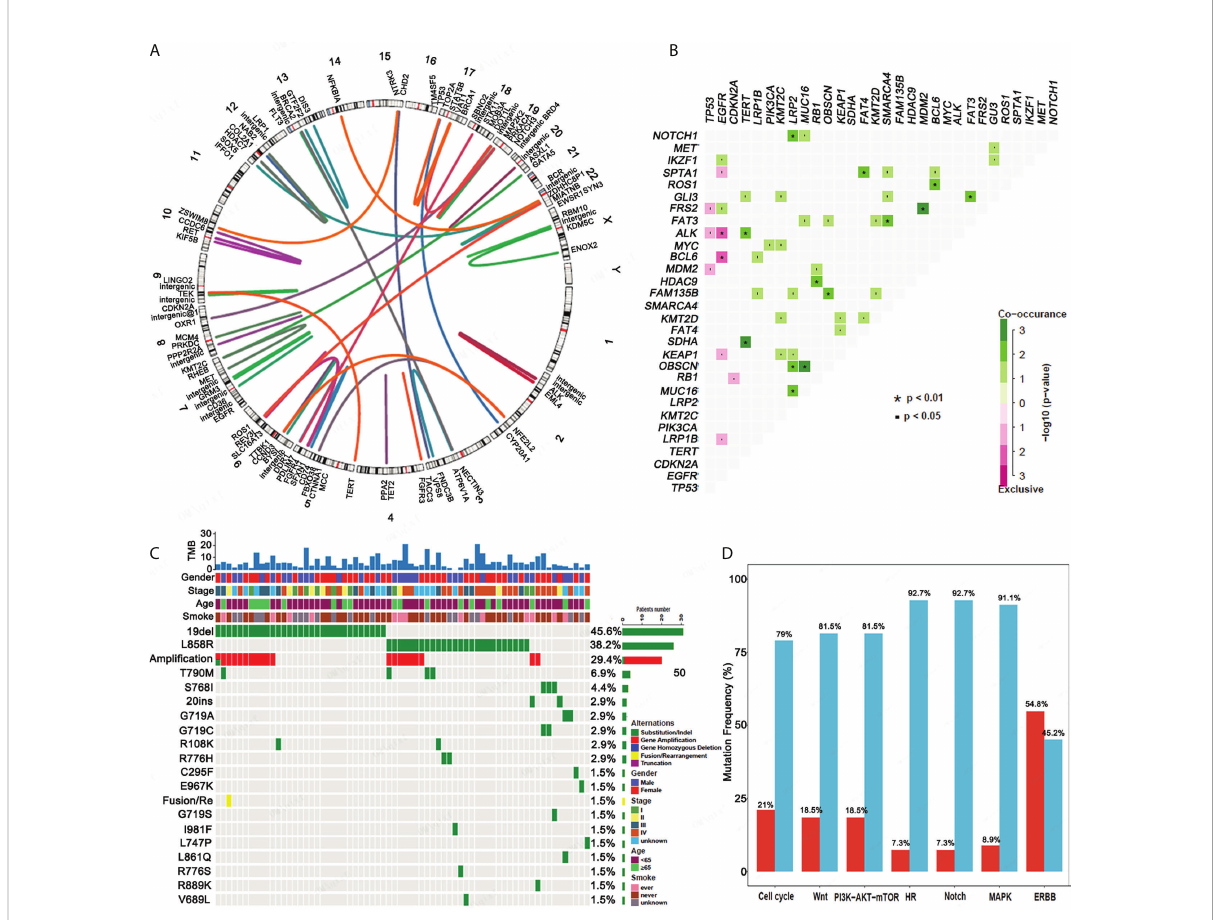
FIGURE 2 Gene fusion, co-mutation, EGFR mutations and mutational gene pathways for ASC. (A) An analysis of the gene fusion/rearrangement characteristics for ASC patients. (B) The co-occurrence of genomic alterations in ASC patients. (C) The frequency of EGFR mutations amongst ASC patients. (D) The frequency of mutational genes in